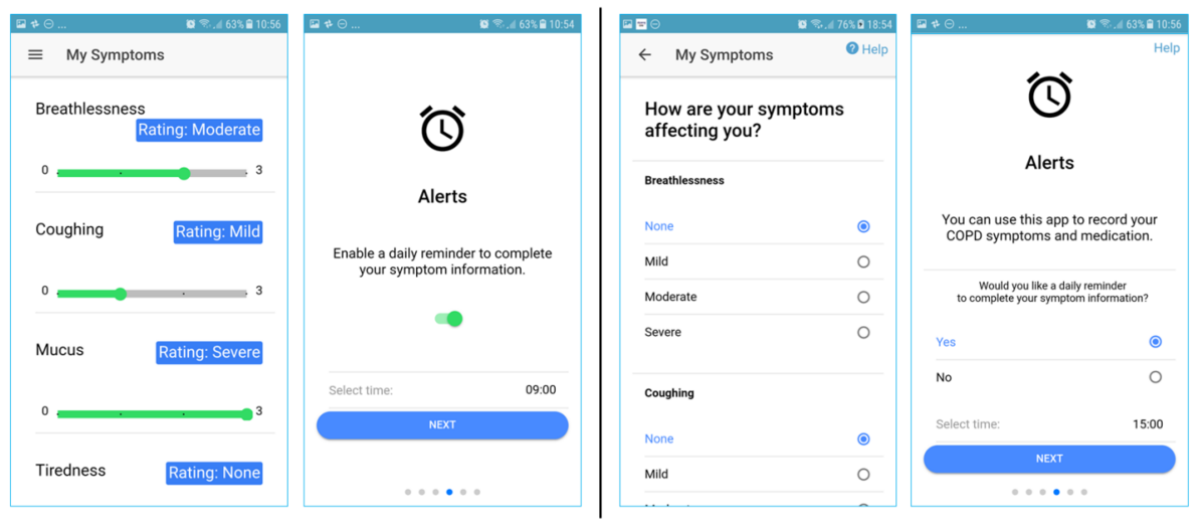
Figure 5. Screenshots of the app pages using slider controls (left of the vertical bar) before they were replaced following user feedback by a more explicit list structure (right of the vertical